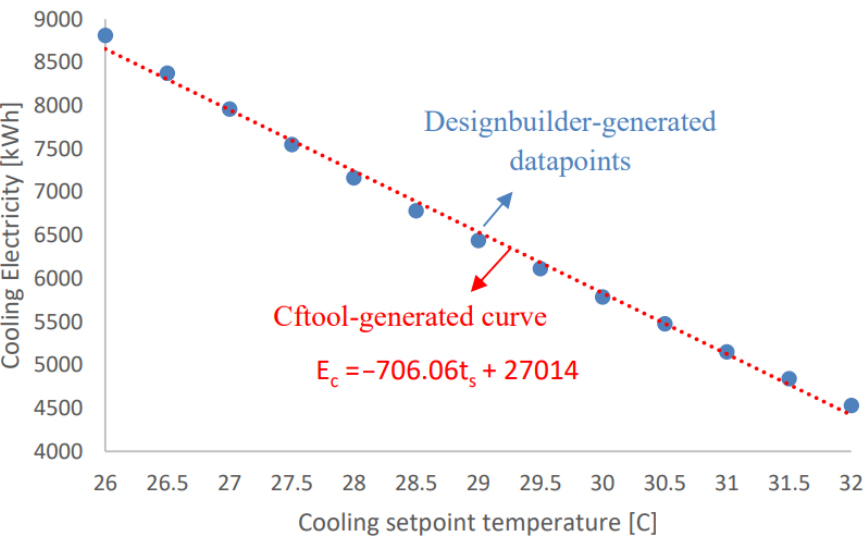
Figure 4. Cooling electricity consumption with respect to the cooling setpoint temperature. The sensitivity of the cooling energy consumption ( 𝐸 (cid:3030) ) towards the cooling setpoint temperature 𝑡 (cid:3046) ( 𝑑𝐸 (cid:3030) 𝑑𝑡 (cid:3046) ⁄ ) was found to be approximately − 706 kWh/ °C , meaning that in- creasing the cooling setpoint temperature by 1 °C would reduce the annual cooling elec- tricity consumption by approximately 706 kWh. Furthermore, to benchmark the effect of cooling setpoint temperature on energy consumption against the ASHRAE criteria (i.e., 𝑡 (cid:3046) =26 °C ), Figure 5 shows the energy reduction percentage for each cooling temperature setpoint with respect to the ASHRAE criteria. The increase in cooling setpoint temperature by an additional 1 °C has the effect of reducing the cooling energy consumption by ap- proximately 8% compared to the ASHRAE cooling setpoint (i.e., 𝑡 (cid:3046) =26 °C ). Figure 5. Energy reduction percentage for each cooling temperature setpoint with respect to the ASHRAE criteria.